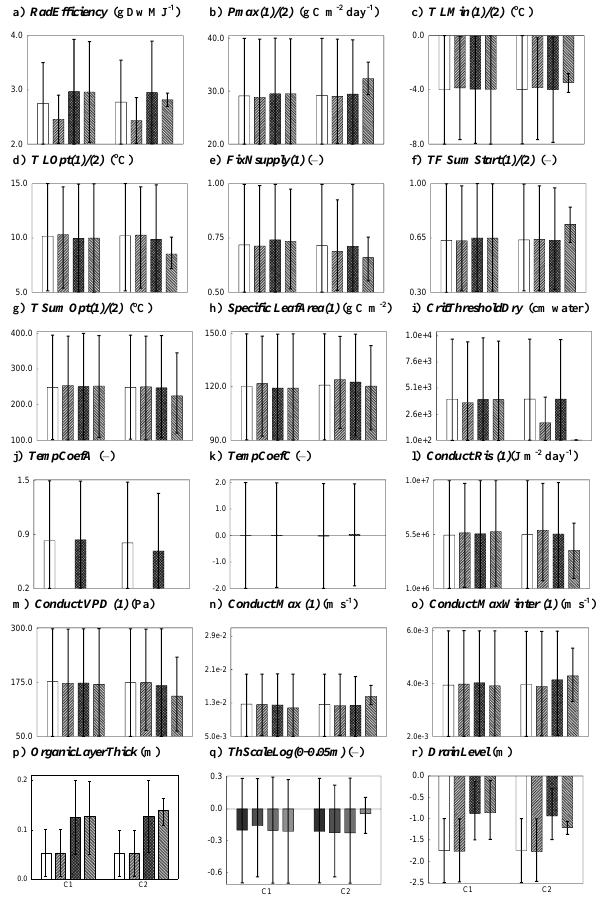
Fig. 8. Influential parameter performance based on DryTs, DryNoTs, MoistTs and MoistNoTs model assumptions when constrained by C1 or C2, respectively. All bars represent mean values and error bars represent min and max values. For legend see Fig. 4.